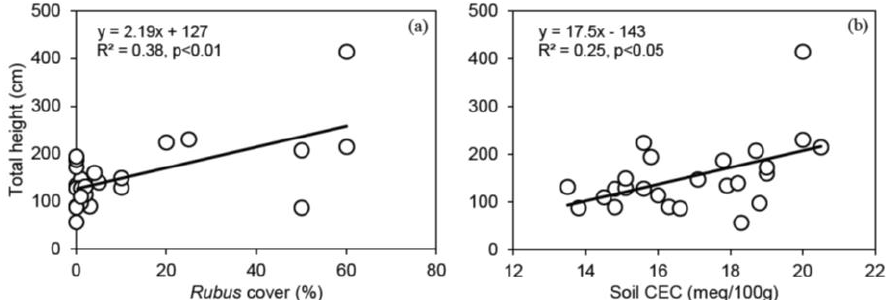
Figure 6. Red oak ( Quercus rubra ) total height after 6 years in the tree shelter treatment as a function of ( a ) cover of Rubus species in the understory and ( b ) soil cation exchange capacity (CEC). N = 25 plots for each relationship. Forests 2018 , 9 , x FOR PEER REVIEW